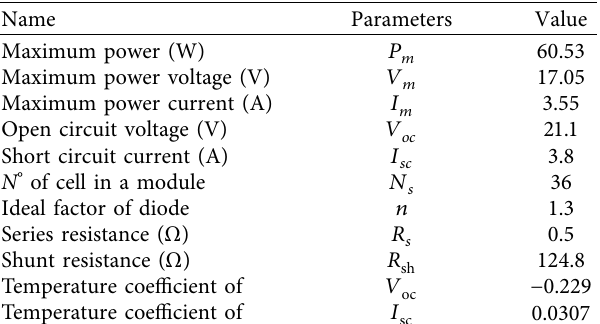
Table 3: PV system parameters.